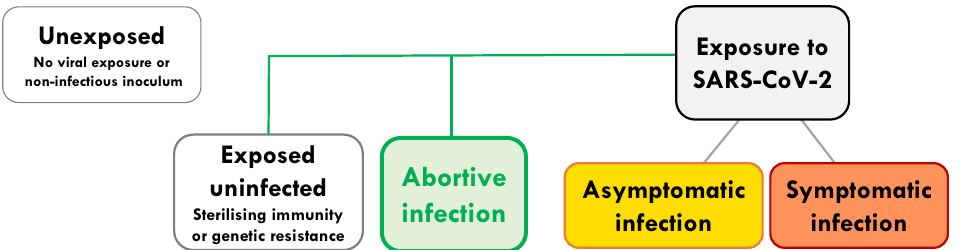
Figure 1. Abortive infection in the spectrum of outcomes from first exposure to SARS-CoV-2. On exposure to SARS-CoV-2 there are a wide range of potential outcomes, such as: exposure without infection (due to sterilising immunity or a cellular genetic resistance); abortive infection, where a low level of infection provides sufficient antigen to expand pre-existing and de novo T cell responses. Abortive SARS-CoV-2 infection can also be identified by raised levels of the interferon stimulated gene, IFI27, in the blood [11]. Abortive infection occurs without induction of systemic antibodies to the virus or sufficient virus to be detectable by PCR. Alternative outcomes are: asymptomatic infection, where the virus and systemic antibodies are detectable in almost all individuals, but no symptoms are induced; symptomatic infection, as with asymptomatic infection, but with measurable symptoms ranging from mild, moderate to severe and fatal infection. Individuals who avoid exposure or have seen only non-infectious inocula, that could not lead to a replicative infection, are considered unexposed.